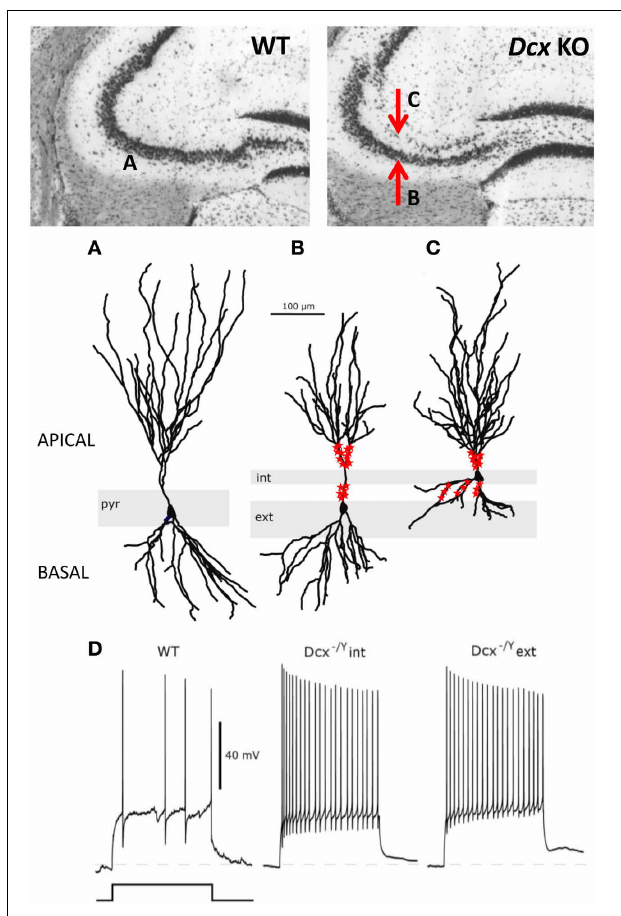
FIGURE 3 | Morphological and functional abnormalities in the Dcx -KO hippocampus. Upper images show coronal slices of the adult Dcx -KO hippocampus (right) compared to wild-type (WT, left). Red arrows in the KO image point to the internal (upper) and external (lower) CA3 layers. Whole cell recordings and biocytin fills were performed to characterize internal (int) and external (ext) pyramidal cells. (A) WT cell; (B) KO external cell; (C) KO internal cell (taken and modified from Bazelot et al., 2012 Figure 5, published by John Wiley & Sons Ltd). Analyses of cell morphologies revealed reduced lengths of apical dendrites for external layer cells and reduced lengths of basal dendrites for internal layer cells (Bazelot et al., 2012). Red labeling on dendrites schematizes mossy fiber innervation in the form of post-synaptic thorny excrescence-like spines. Note non-continuous innervation on apical dendrites of external layer cells, and basal as well as apical innervation on internal layer cells (schematizing data presented in Bazelot et al., 2012, Figure 4). (D) Whole cell recordings taken from Bazelot et al. (2012) Figure 6 (published by John Wiley & Sons Ltd) revealed that